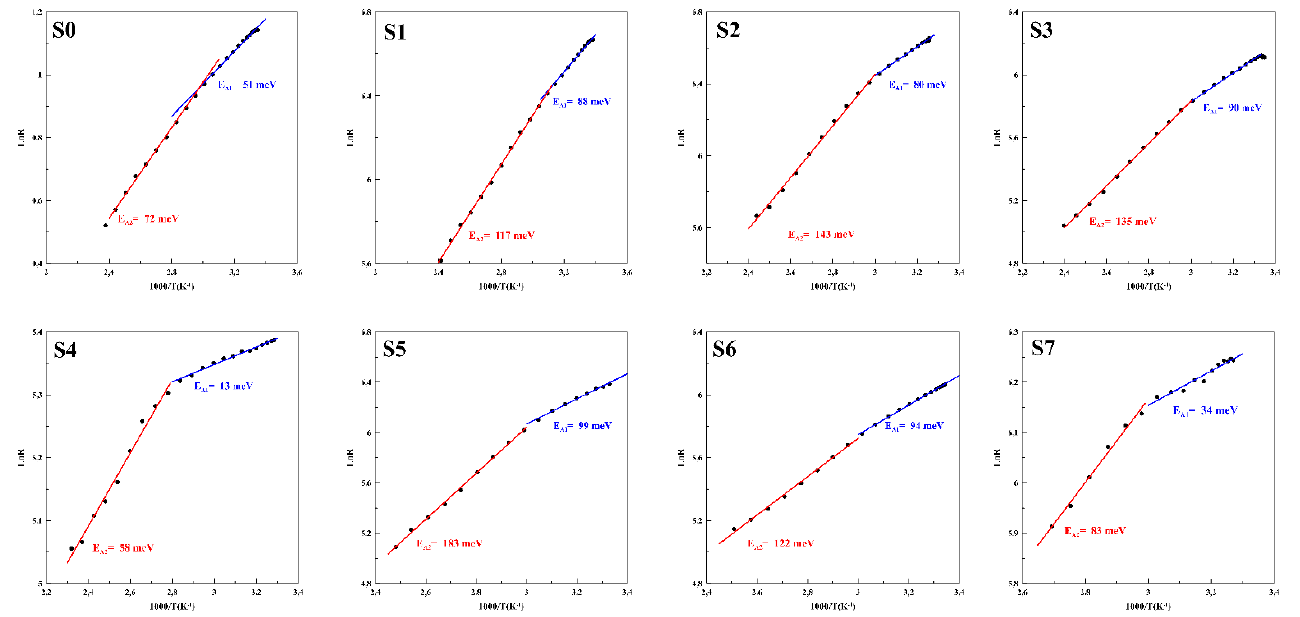
Figure 10. Ln ( R ) vs. 1000/ T graphs of the films within the temperature range of 300–723 K. Figure 10. Ln (R) vs. 1000/𝑇 graphs of the films within the temperature range of 300–723 𝐾 . Table 5. Activation energies of pure and B doped ZnO thin films for both low- and high-temperature